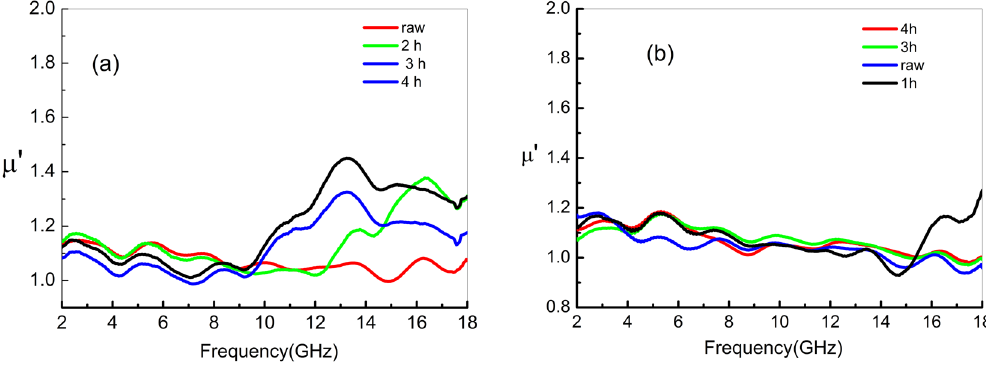
Figure 6. Real part ( μ′ ) of the complex permeability of CNT composites heat-treated for 2, 3, and 4 h at temperatures of 700 °C and 900 °C; μ′ of the untreated composites is denoted as 0 h.